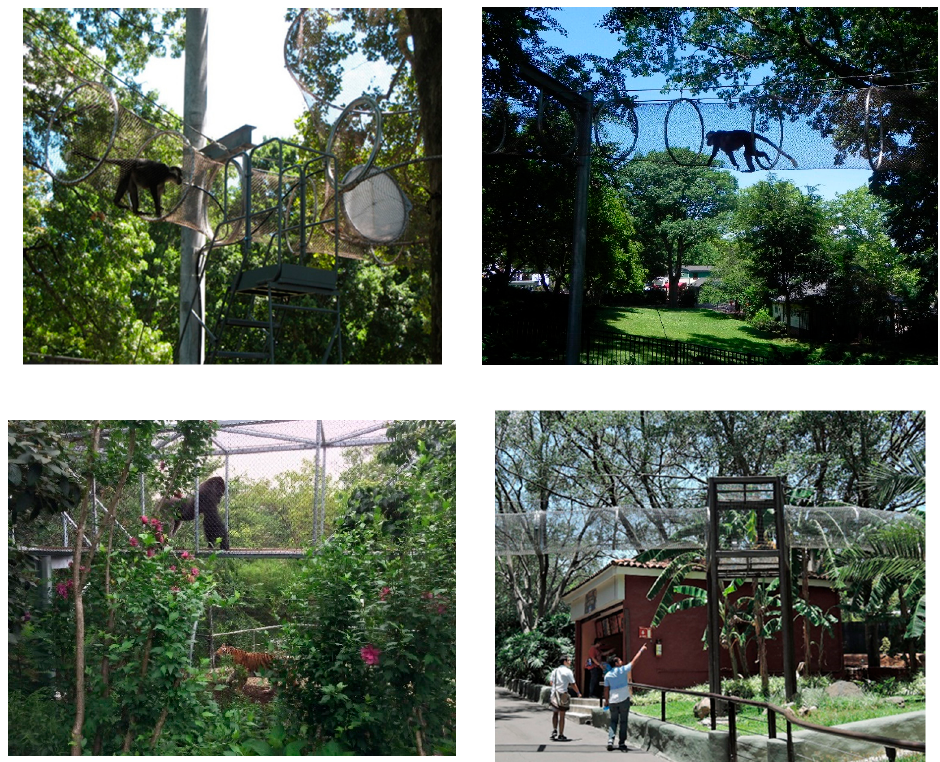
Figure 7. Upper photos of Tree Top Trail (Photos: J. Coe), lower left photo of Great Ape trail above Big Cat Trail (Photo: Philadelphia Zoological Society). Lower-right Sendarios, Zoo Guadalajara, Mexico (Photo: J. Coe).